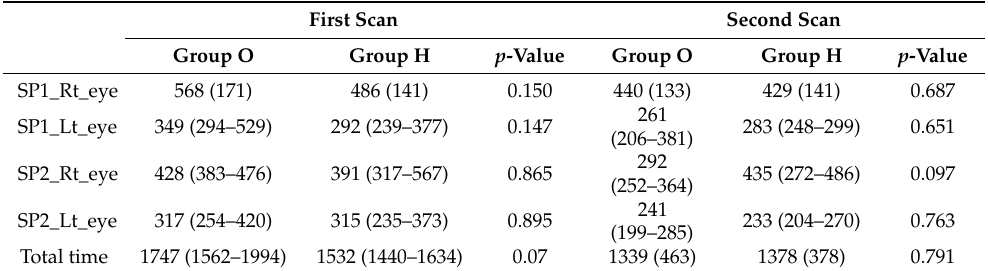
Table A4. The time taken to scan ocular POCUS.